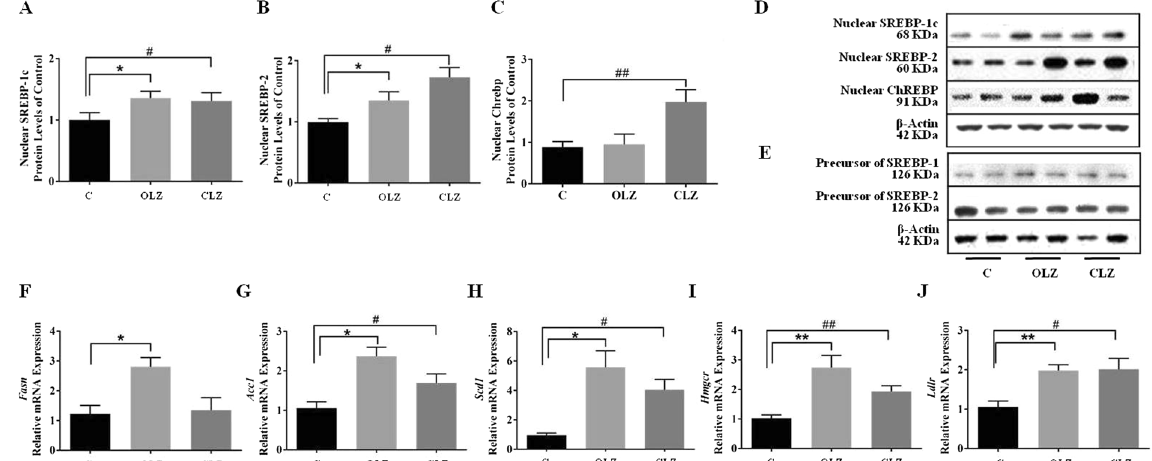
Figure 3. Effects of antipsychotic drugs on the SREBP and ChREBP pathway. Western blot analysis of the protein expression of hepatic ( A ) nuclear SREBP-1c, ( B ) nuclear SREBP-2, and ( C ) nuclear ChREBP protein after 9-week treatment of OLZ and CLZ. A representative blot is shown ( D and E ). The mRNA expression of their target genes was quantified and normalized to β -actin and gapdh by qPCR: Fasn ( F ), Acc1 ( G ), Scd1 ( H ), Hmgcr ( I ), and Ldlr ( J ). Data represent mean ± SEM of 2 independent experiments done in duplicate (n = 6 per group). * p < 0.05, ** p < 0.01, and *** p < 0.001: OLZ treatment vs. control, # p < 0.05, ## p < 0.01, and